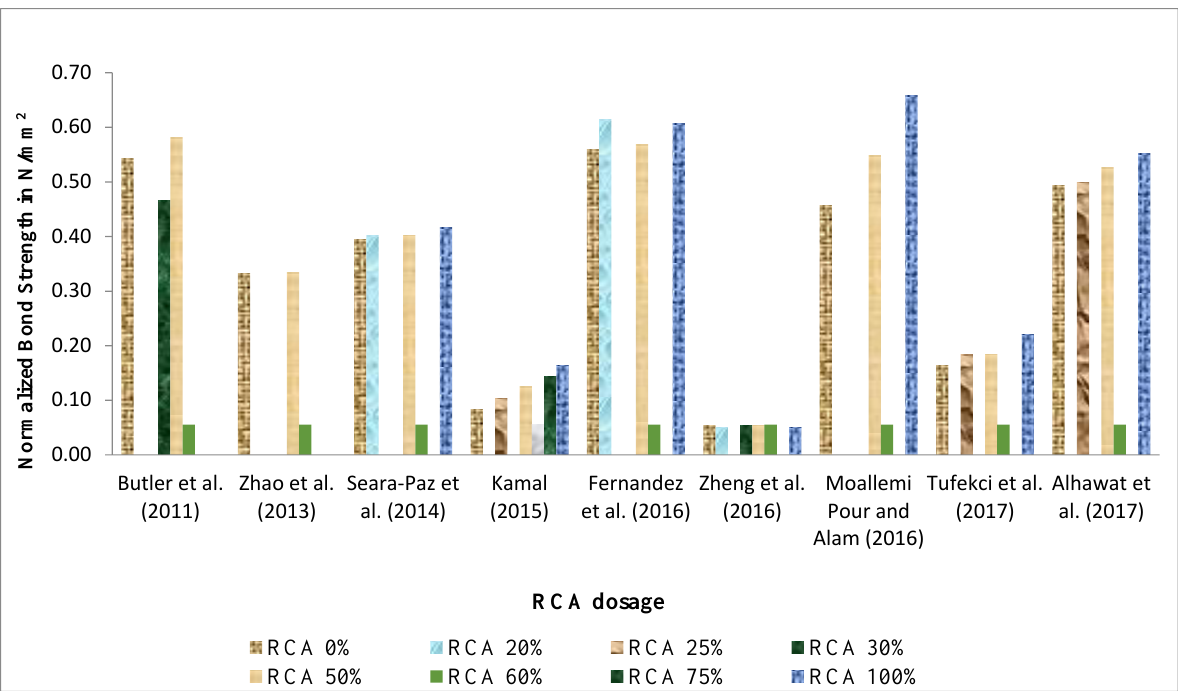
Figure 6. Bar chart comparing normalized bond strength in terms of dosage of RCA [13,18,43,55 – 57,60 – 62].